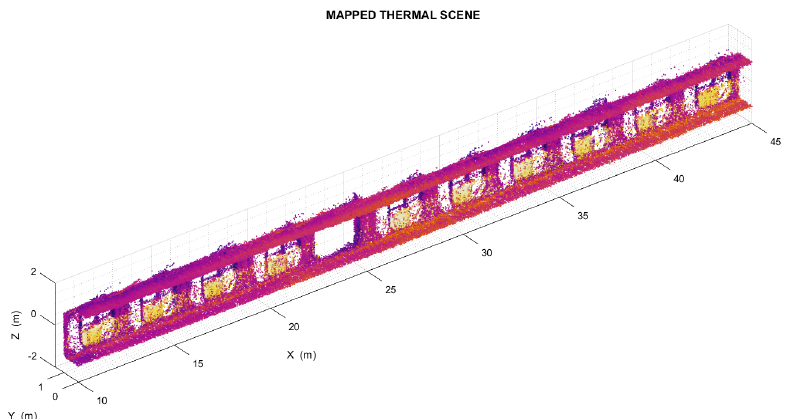
Figure 7. Visual ( left ) and thermal ( right ) images of the indoor environment used to test the proposed algorithm. Notice how the thermally distinctive elements on both sides of the corridor are still recognizable in the thermal scene (Figure 8) as well as in the corresponding temperature maps (Figure 9a,b).